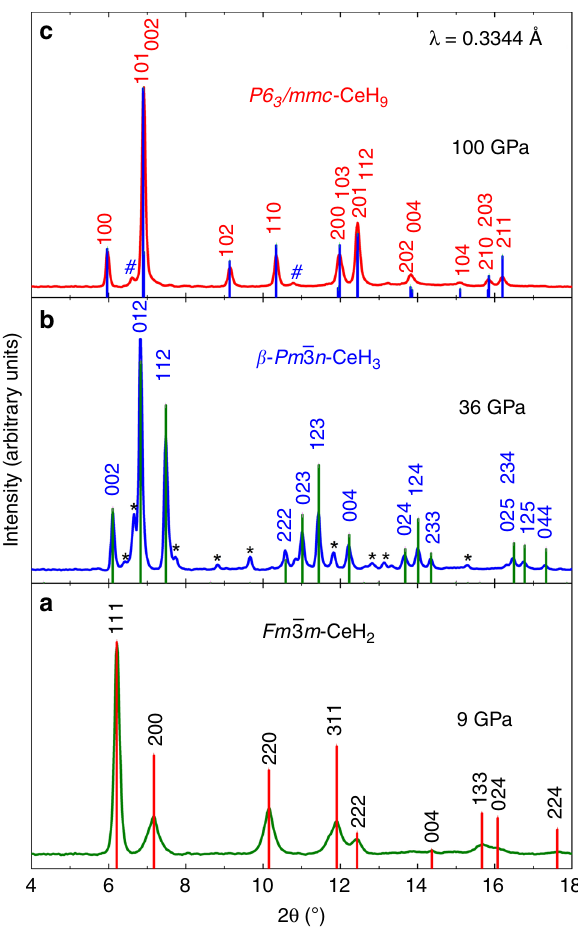
Fig. 1 Representative integrated XRD patterns of high-pressure phases in Ce – H system up to 100 GPa. Typical XRD patterns of a CeH 2 , b CeH 3 , and c CeH 9 obtained at 9, 36, and 100 GPa of pressure respectively. Vertical lines indicate the indexing with calculated intensity for respective crystal structure. CeH 2 , CeH 3 , and CeH 9 crystallize in space group Fm (cid:1) 3 m , Pm (cid:1) 3 n ( β -UH 3 type) and P6 3 /mmc , respectively. Unidenti fi ed weak peaks in b and c are marked with black asterik and blue hash symbols, respectively. These additional peaks could not be identi fi ed or indexed with any of the known or predicted phases of Ce 68 or CeH x 23 , as well as cerium oxides phase (Supplementary Fig. 1c). The lattice parameters of CeH 2 at 9 and 33 GPa were determined as a = 5.370(1) and a = 5.011(2) Å respectively. Pressure dependence of the unit cell volume of CeH 2 was fi tted with a third-order Birch – Murnaghan equation of state (EOS) which yielded the fi tting parameters such as unit cell volume at zero pressure V 0 = 44(1) Å 3 per f.u., bulk modulus K 0 = 45(6) GPa and fi rst pressure derivative of bulk modulus K 0 ′ = 4 ( fi xed) (Supplementary Fig. 1d). Pressurization of CeH 2 up to 33 GPa did not result in any changes in crystal structure.